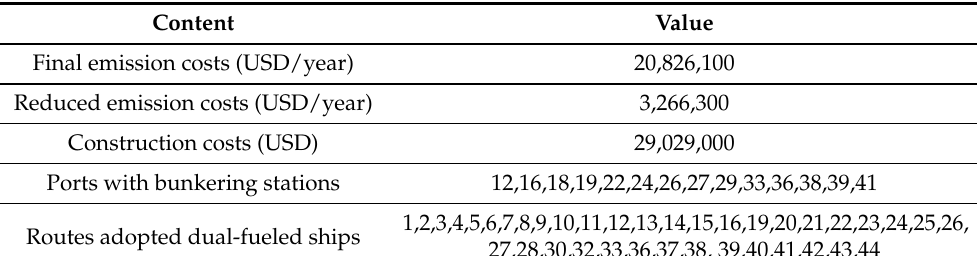
Table 1. Detailed information of the case study result.